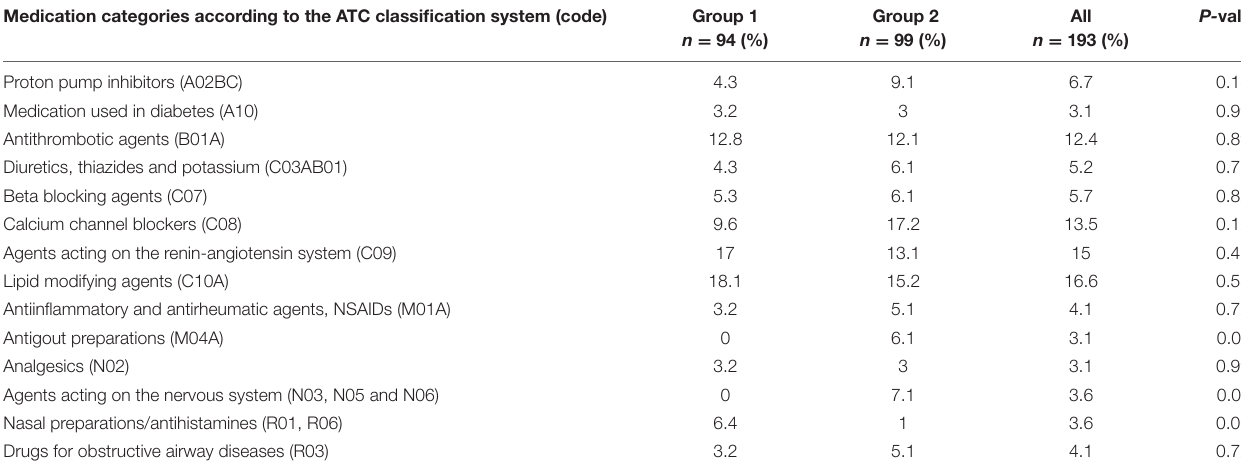
TABLE 2 | Self-reported daily intake of prescribed medication by the 193 male participants born in 1953.